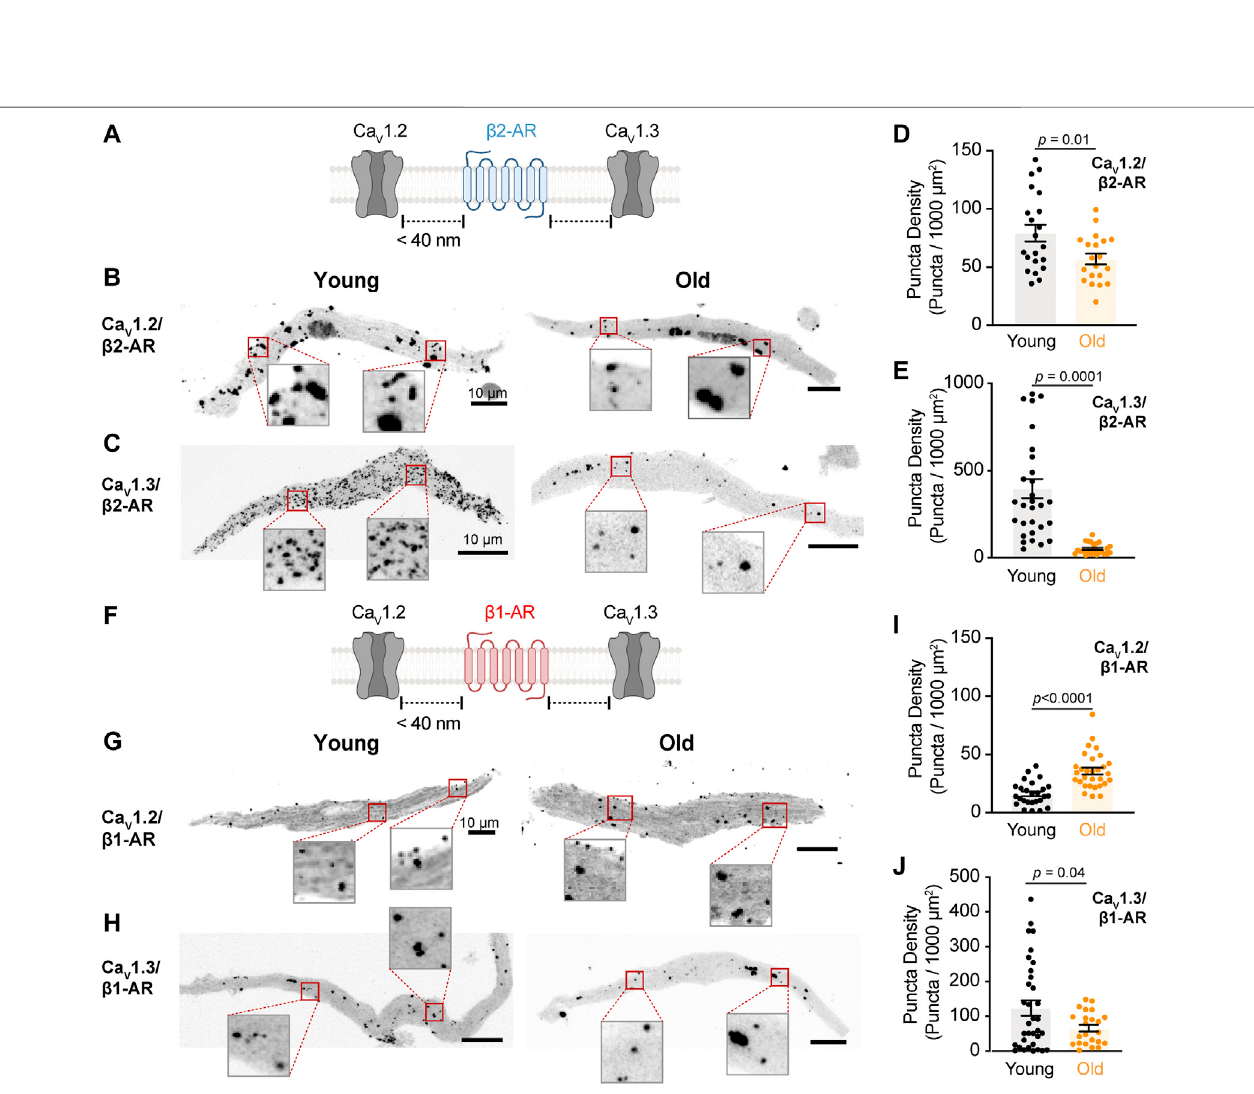
FIGURE 3 | The physical association between L-type calcium channels and β 2-AR is reduced in old pacemaker cells. (A) Diagrammatic representation of the molecular association being tested between β 2-AR and speci fi c LTCCs. Diagram created with BioRender.com. (B) Representative pictures of proximity ligation assay (PLA) between β 2-AR and Ca V 1.2 channels in young and old pacemaker cells. (C) Representative PLA pictures between β 2-AR and Ca V 1.3 channels in young and old pacemakercells. (D) Comparison ofthepunctadensityformed bytheassociationof β 2-ARwithCa V 1.2channelsbetweenyoung(n=21cells,N=3mice)and old (n = 20 cells, N = 3 mice). (E) Comparison of the puncta density formed by the association of β 2-AR with Ca V 1.3 channels between young (n = 30 cells, N = 3 mice) and old (n = 24 cells, N = 3 mice). (F) Diagrammatic representation of the molecular association being tested between β 1-AR and speci fi c LTCCs. (G) Representative PLA picturesbetween β 1-ARandCa V 1.2channelsinyoungandoldpacemakercells. (H) RepresentativePLApicturesbetween β 1-ARandCa V 1.3channelsinyoungandold pacemakercells. (I) Comparisonofthepunctadensityformedbytheassociationof β 1-ARwithCa V 1.2channelsbetweenyoung(n=26cells,N=3mice)andold(n=30 cells, N = 3 mice). (J) Comparison of the puncta density formed by the association of β 1-AR with Ca V 1.3 channels between young (n = 34 cells, N = 3 mice) and old (n = 23 cells, N = 3 mice). Statistical comparison used an unpaired t-test with signi fi cance at p < 0.05.